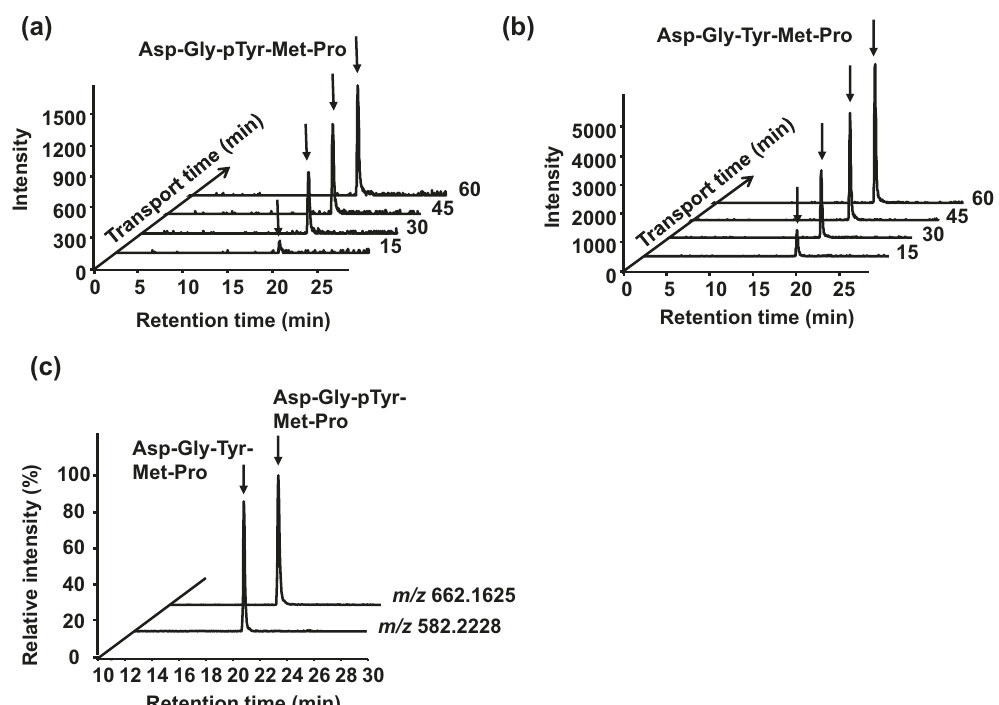
Fig. 1 Transport of Cblin pentapeptides in Caco-2 cells. Chromatograms show apical to basolateral transepithelial transport of 1 mM Asp- Gly-pTyr-Met-Pro ( a ) and Asp-Gly-Tyr-Met-Pro ( b ) in Caco-2 cell monolayers over 60 min. Samples from the basolateral side at 15, 30, 45, and 60 min were analyzed using LC – TOF/MS with [M + H] + at m / z 662.1625 for Asp-Gly-pTyr-Met-Pro and 582.2228 for Asp-Gly-Tyr-Met-Pro. ( c) Dephosphorylation of Asp-Gly-pTyr-Met-Pro monitored in basolateral solution after 60 min of transport by extracting ions with m / z 582.2228 corresponding to Asp-Gly-Tyr-Met-Pro ions. Table 1. Apparent permeability coef fi cient ( P app ) of Asp-Gly-pTyr-Met- Pro and Asp-Gly-Tyr-Met-Pro in Caco-2 cell monolayers. P app (×10 − 7 cm/s)